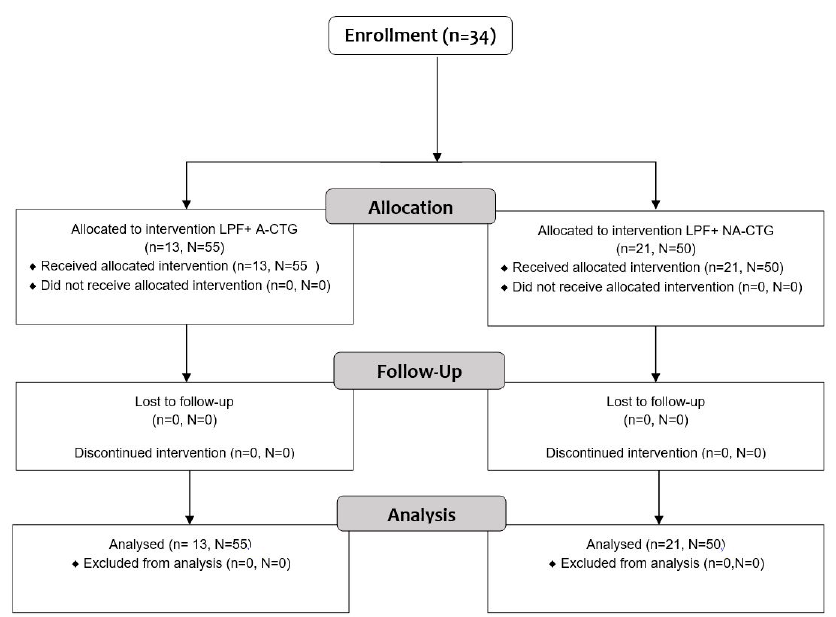
Figure 2. Consort flowchart of the study. LPF, laterally positioned flap; A-CTG, augmented connective tissue graft; NA-CTG, nonaugmented connective tissue graft; n—number of subjects, N—number of gingival recessions